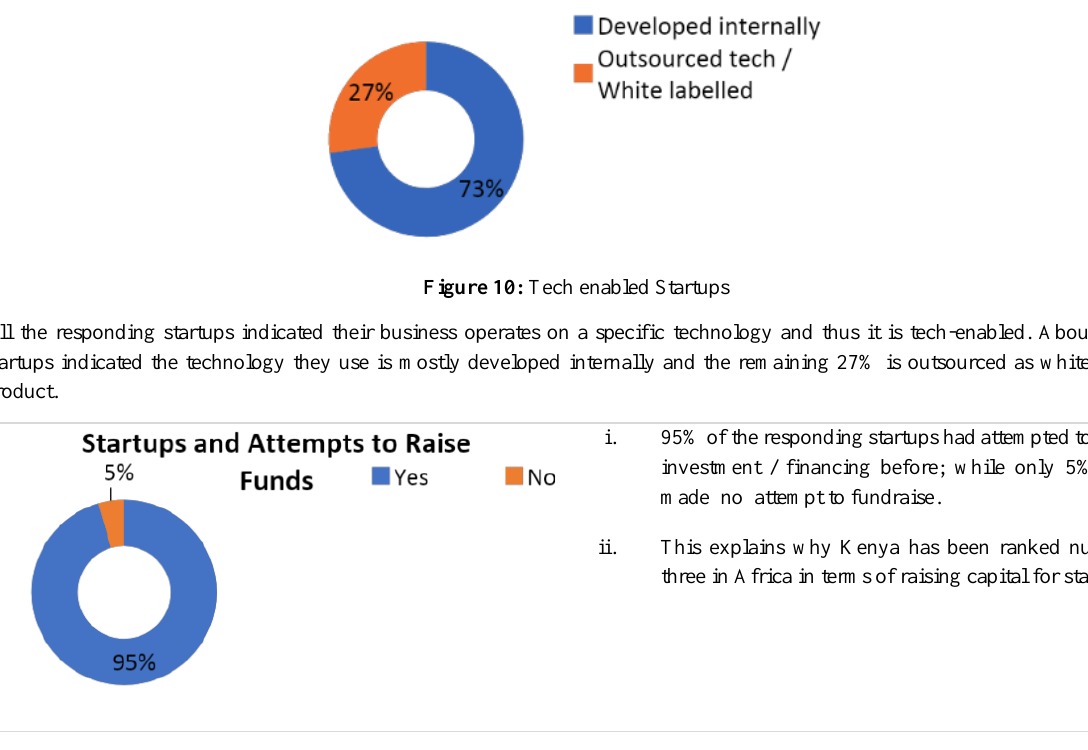
Figure 11: Startups attempt to raise Capital